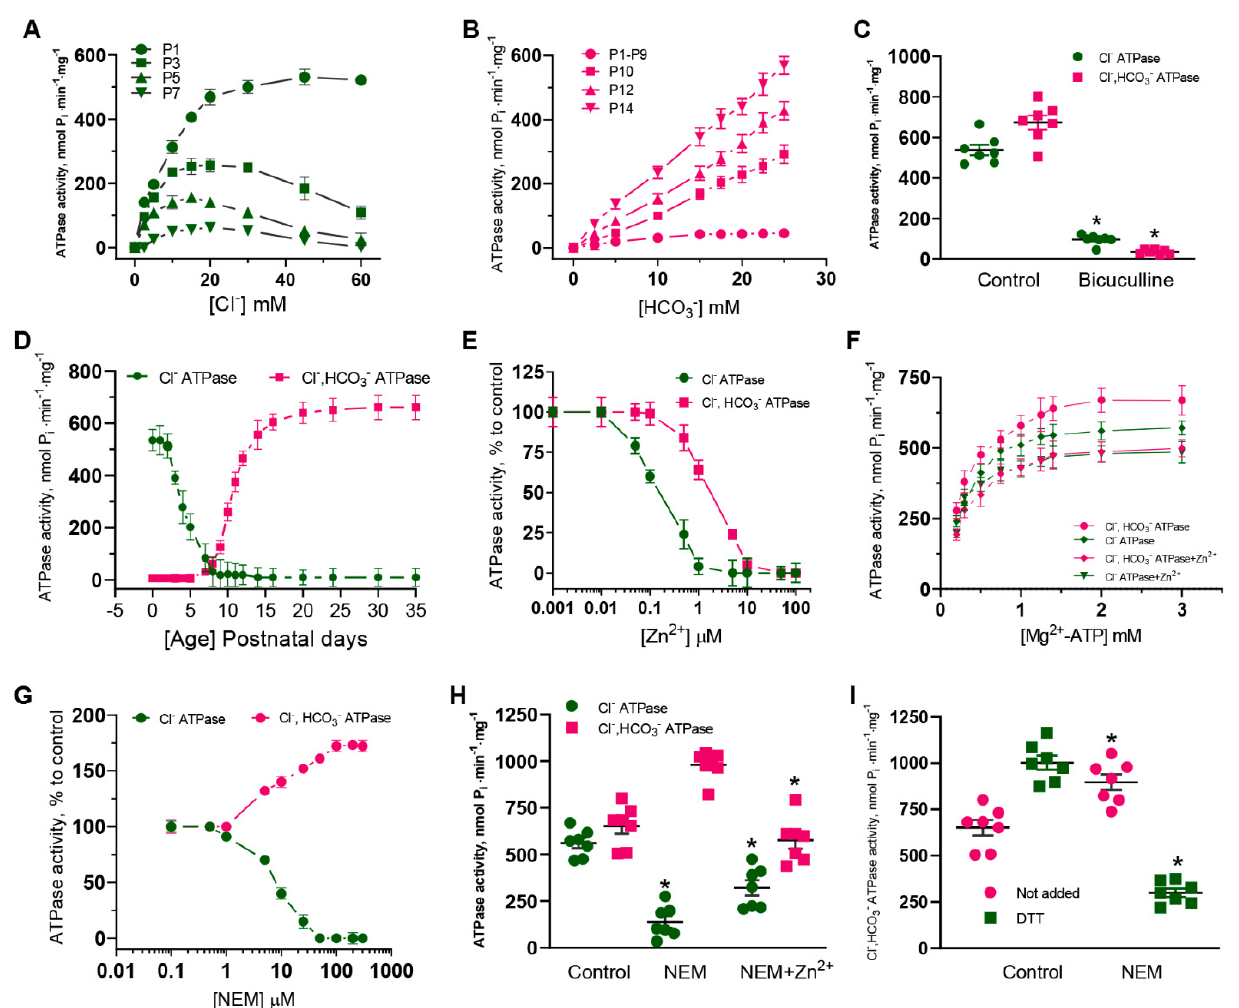
Figure 1. Zinc potency for ATPase activity is affected from brain development. ( A ) Cl − concentration activation curves determined for ATPase of the plasma membranes performed from cerebral cortex during P1–P7 days ( n = 7). ( B ) HCO 3 − concentration activation curves measured for ATPase of the plasma membranes performed from cerebral cortex during P1–P14 days ( n = 5). ( C ) Bar chart showing average maximum Cl − - and Cl − , HCO 3 − ATPase activities before and after 40 µM bicuculline application: Student’s unpaired t -test, p < 0.0001 ( n = 7) and p < 0.0001 ( n = 7). ( D ) Curves of Cl − - or Cl − , HCO 3 − ATPase activities determined in the plasma membranes performed from cerebral cortex during P1-P30 days ( n = 7). ( E ) Zn 2+ concentration inhibition curves for Cl − - or Cl − , HCO 3 − ATPase activities ( n = 5). ( F ) Mg 2+ -ATP concentration activation curves determined for Cl − - or Cl − , HCO 3 − ATPase activities before and after 20 µM Zn 2+ application. ( G ) NEM concentration modulation curves determined for Cl − - or Cl − , HCO 3 − ATPase activities. ( H ) Bar chart showing average maximum Cl − - or Cl − , HCO 3 − ATPase activities before or after 300 µM NEM and 300 µM NEM + 20 µM Zn 2+ in an experimental medium: Student’s unpaired t -test, p < 0.0001 ( n = 7), p < 0.0001 ( n = 7), p = 0.4387 ( n = 7) and p < 0.0001 ( n = 7). ( I ) Bar chart showing average maximum Cl − , HCO 3 − ATPase activity before or after 300 µM NEM or 300 µM NEM + 2 mM DTT application: Student’s unpaired t -test, p < 0.0015 ( n = 7) and p < 0.0001 ( n = 7). Data are presented as mean ± SEM. * p < 0.05, ns, not significant.